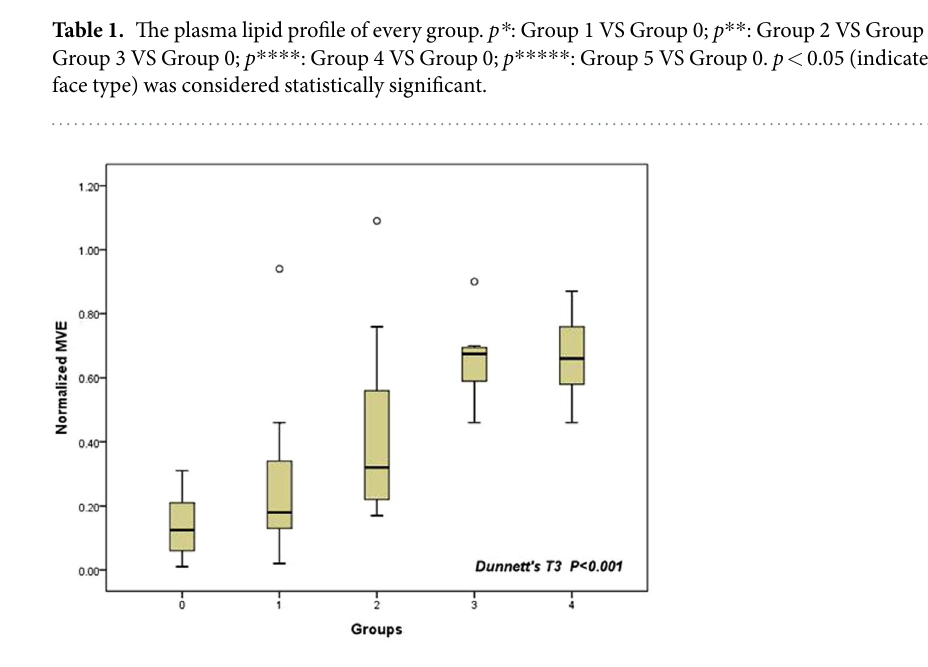
Figure 2. Normalized maximal video-intensity enhancement of the adventitial vasa vasorum in different